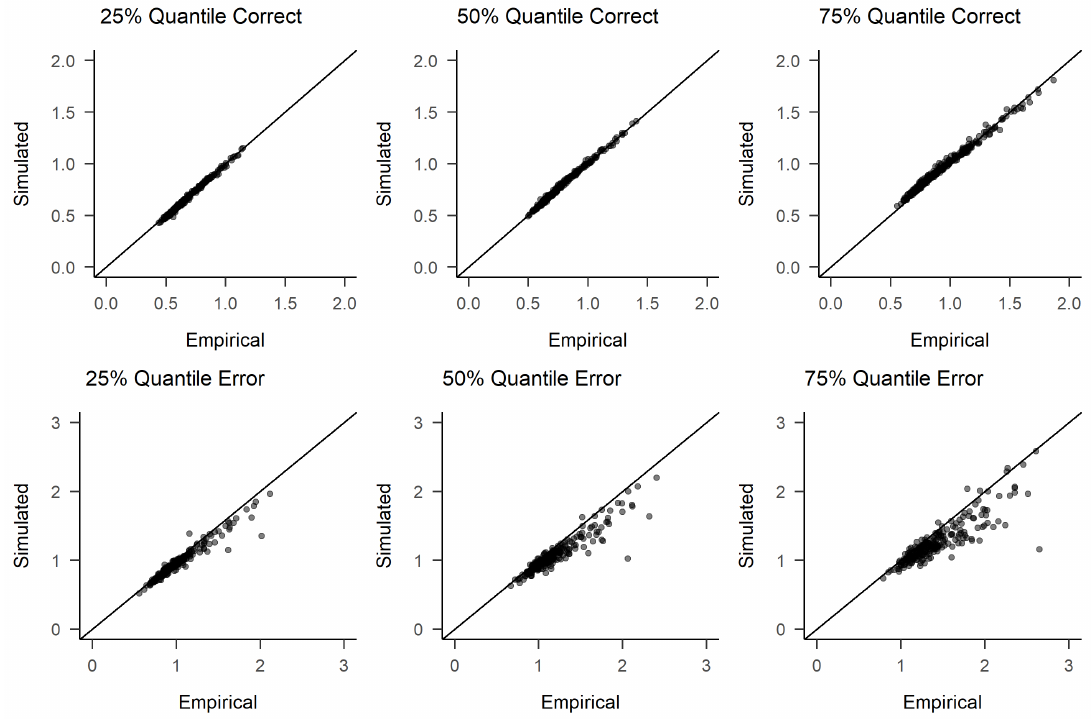
Figure A2. Posterior predictive check of RTs for T3. Participants with 10 or less errors are omitted from the error response time